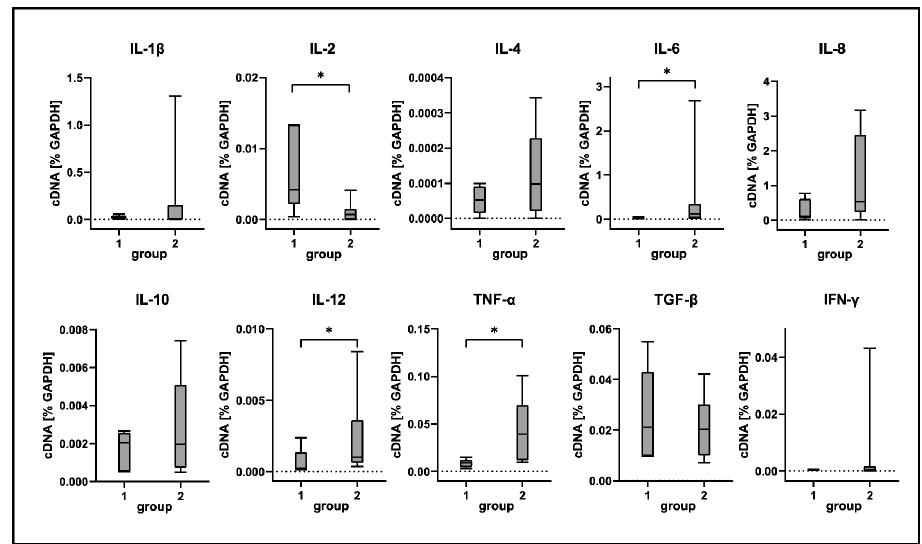
Figure 8. Cytokine expression analyses of canine distemper virus (CDV)-infected lung tissue. IL = interleukin; TNF- α = tumor necrosis factor alpha; TGF- β = transforming growth factor beta; IFN- γ = interferon gamma. Groups: 1 = non-infected control lungs; 2 = acute CDV infection; box and whisker plots display median and quartiles with maximum and minimum values. Significant differences ( p ≤ 0.05, Kruskal–Wallis H test) are labeled by asterisks.